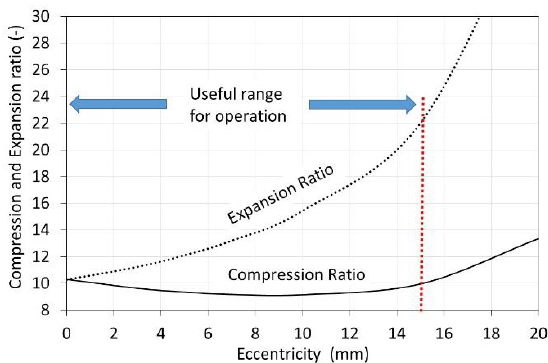
Fig. 10. Expansion and compression ratio vs. eccentricity